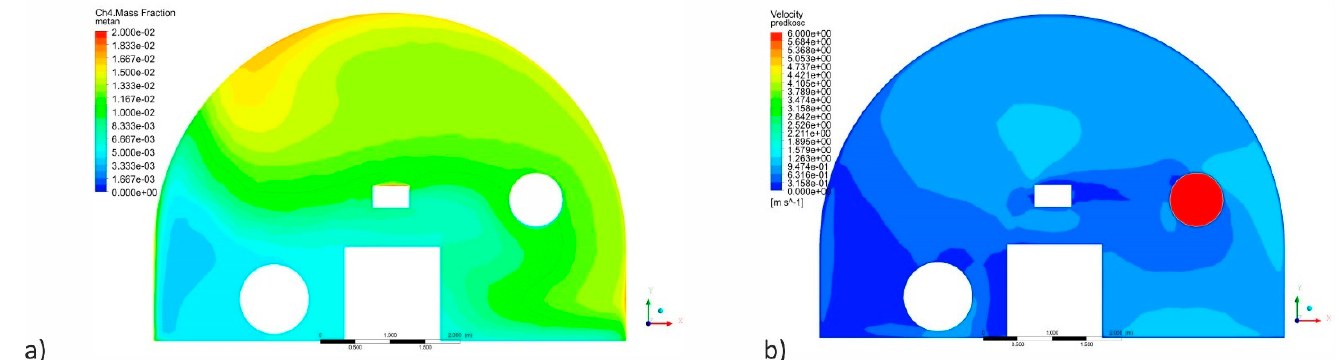
Figure 12. Cross ‐ section of roadway at the distance of 29 m to the face for the case L o = 10 m, ( a ) methane concentration field, ( b ) air velocity field.